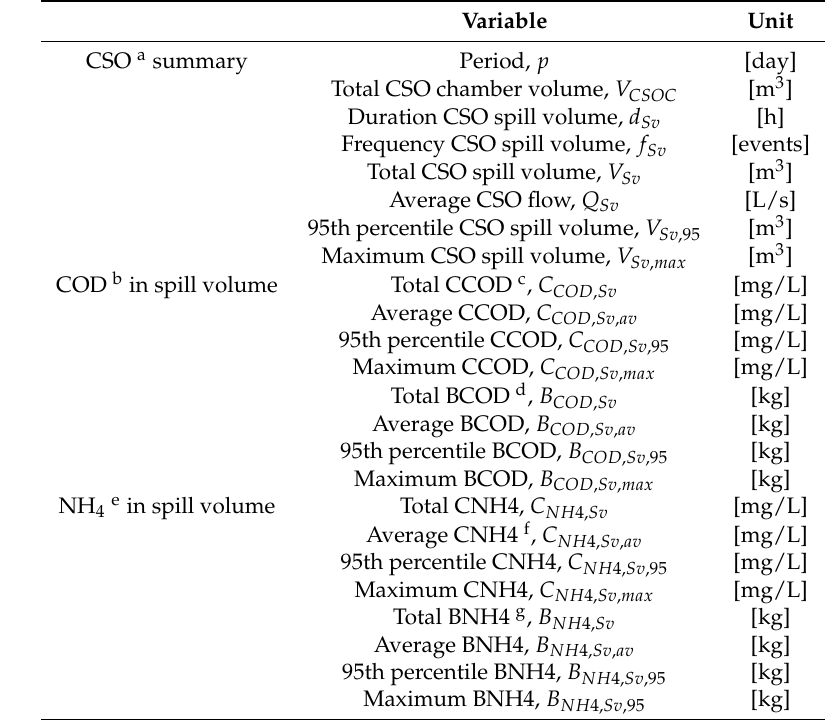
Table 2. Output variables of the EmiStatR